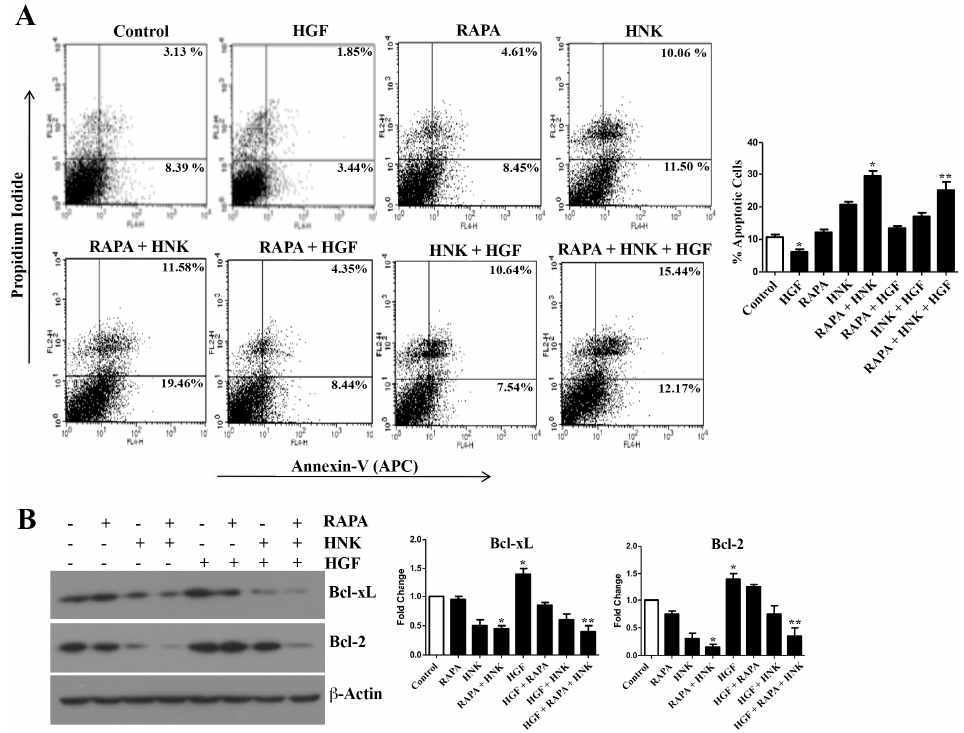
Figure 4. Honokiol (HNK) down ‐ regulates HGF ‐ mediated anti ‐ apoptotic signals and promotes renal cancer cell apoptosis. ( A ) 786 ‐ 0 cells were treated with RAPA (15 μ M) and Honokiol (40 μ M) either